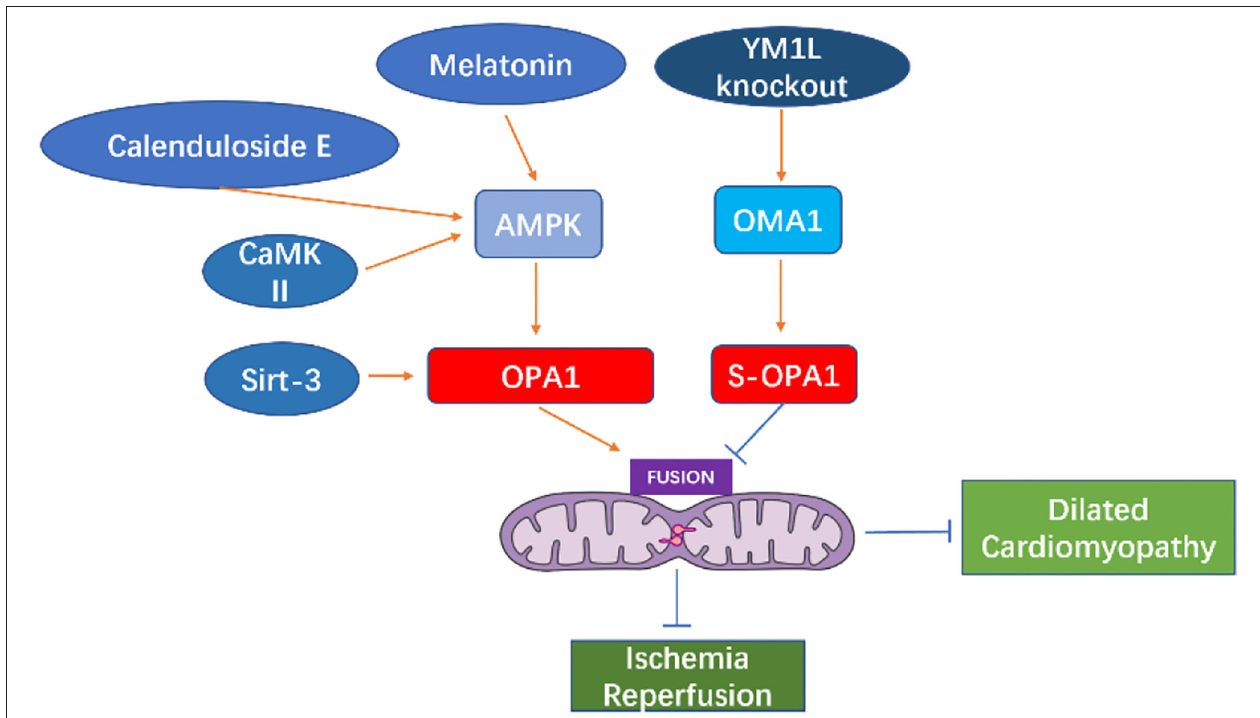
FIGURE 5 | Cell signal transduction pathway acting on OPA1 and its role in heart disease.